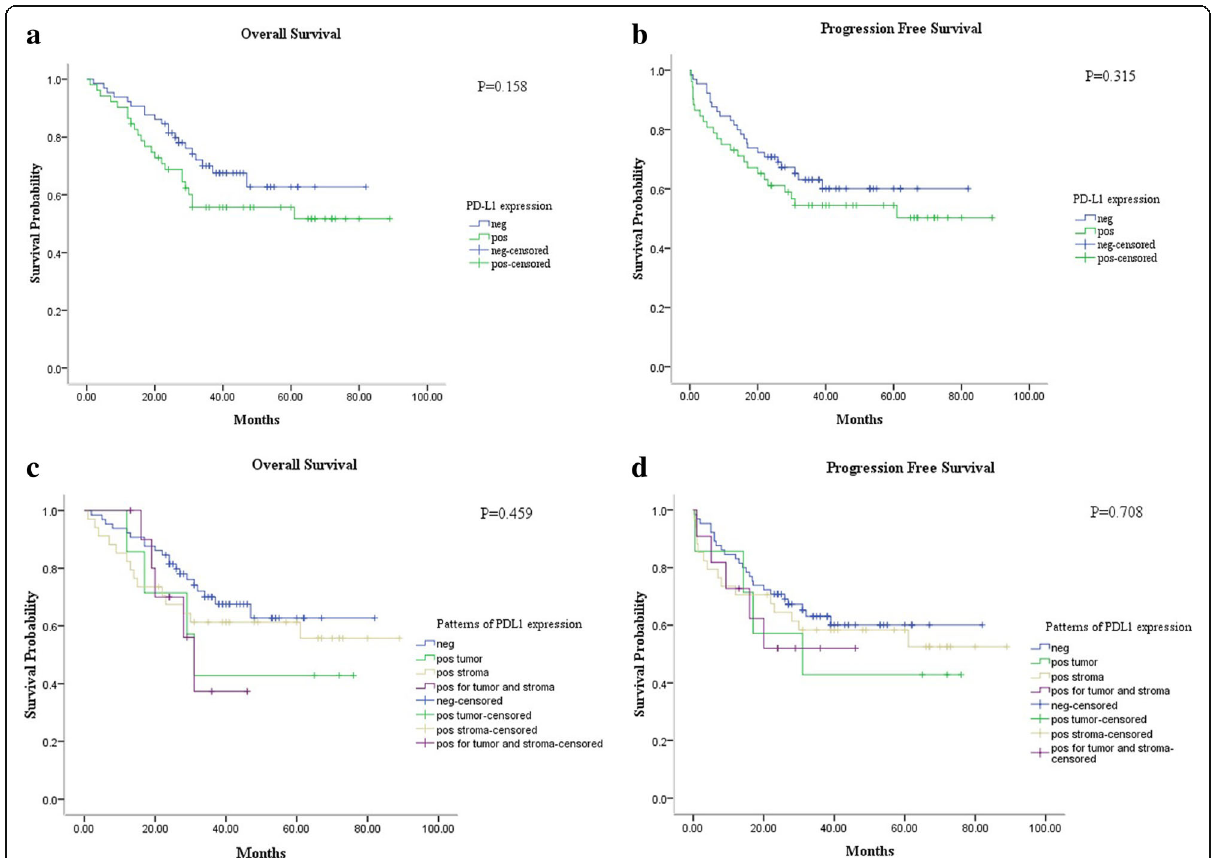
Fig. 2 Kaplan-Meier survival curves of OS and PFS for PD-L1 were performed. The PD-L1 expression has a trend with decreased OS ( p = 0.158) ( a ) and PFS ( p = 0.315) ( b ) but did not reach the significant level. Similarly, the PD-L1 positive target cells were further classified as tumor cells and immune cells. We found that expression on tumor cells seemed to have poorer OS ( p = 0.459) ( c ) and PFS ( p = 0.708) ( d ) than in immune